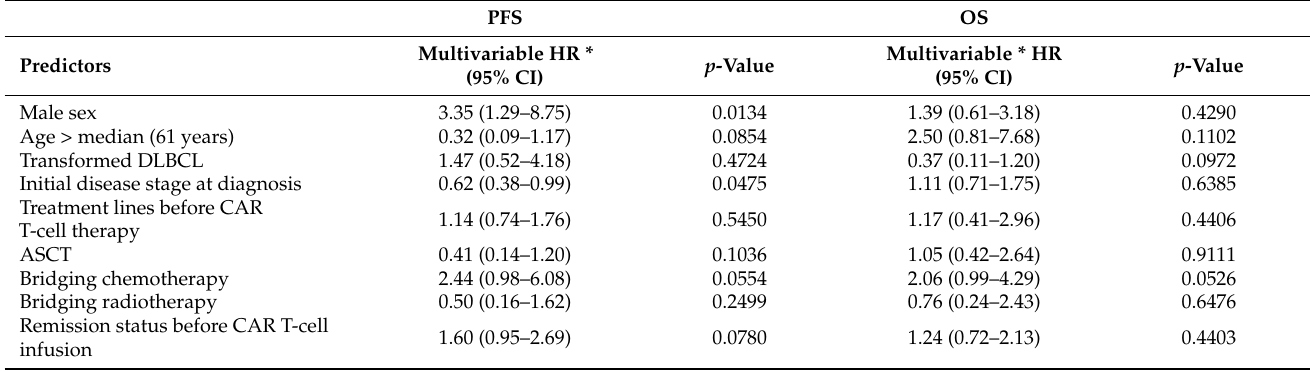
Table 6. Correlation of multiple predictors with PFS and OS after CAR T-cell